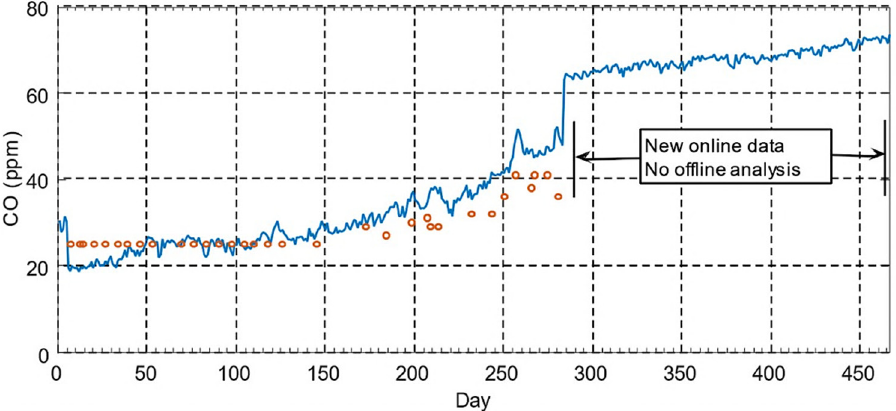
Figure 34. Evolution of carbon monoxide (CO) concentration over time, online (blue) and offline (orange) data.